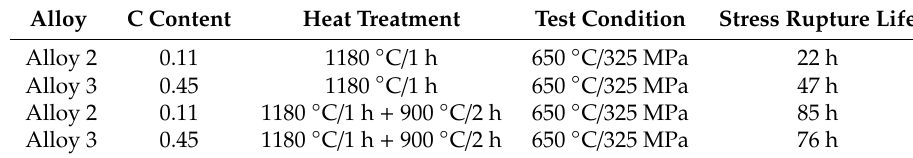
Table 2. Stress rupture life of the alloys with different C content